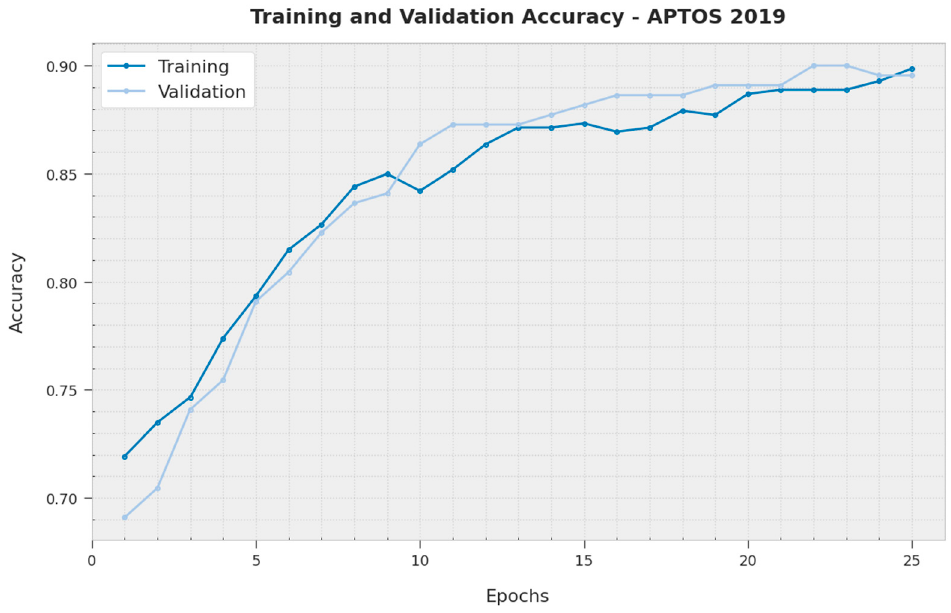
Figure 5. TA and VA analysis of the XAITO-DRGC approach under the APTOS 2019 dataset. The training loss (TL) and validation loss (VL) gained by the XAITO-DRGC method- ology on the APTOS 2019 dataset are established in Figure 6. The experimental outcome